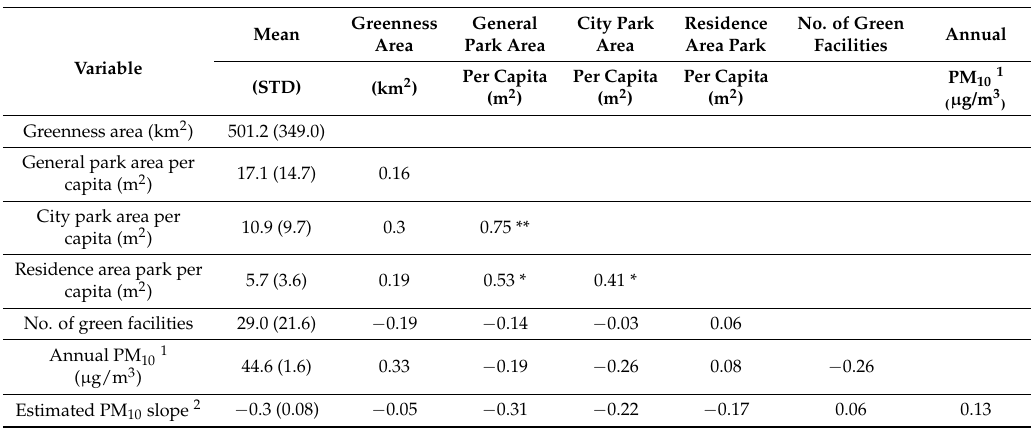
Greenness General City Park Mean Area Park Area